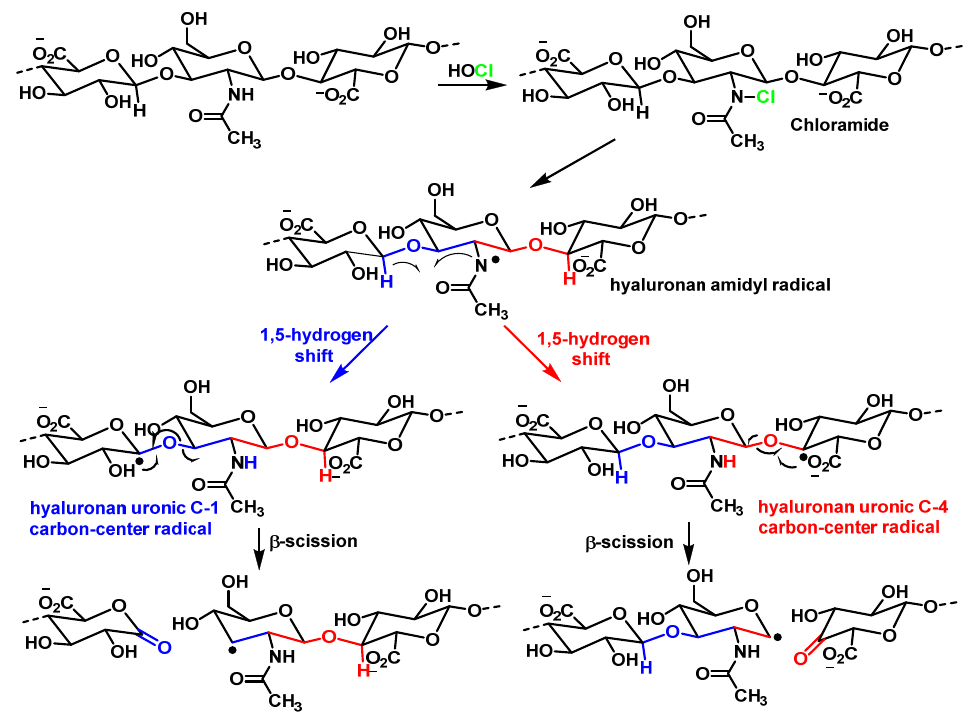
Figure 48. Scheme of N -centred amidyl-radical formation and transformation into C-centred radical with the fragmentation of the polysaccharide chain during the reaction of HOCl with the acetylamide-group of hyaluronic acid.